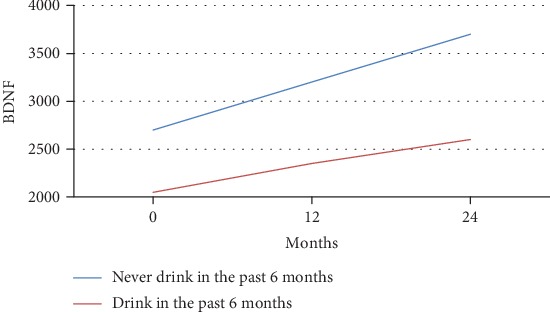
BDNF by the drinking group for adolescents younger than 15 years of age. As depicted, the analysis shows significant changes during time within each group within a linear mixed model. Nondrinkers under 15 experienced a sharper incline in m-BDNF level than drinkers.